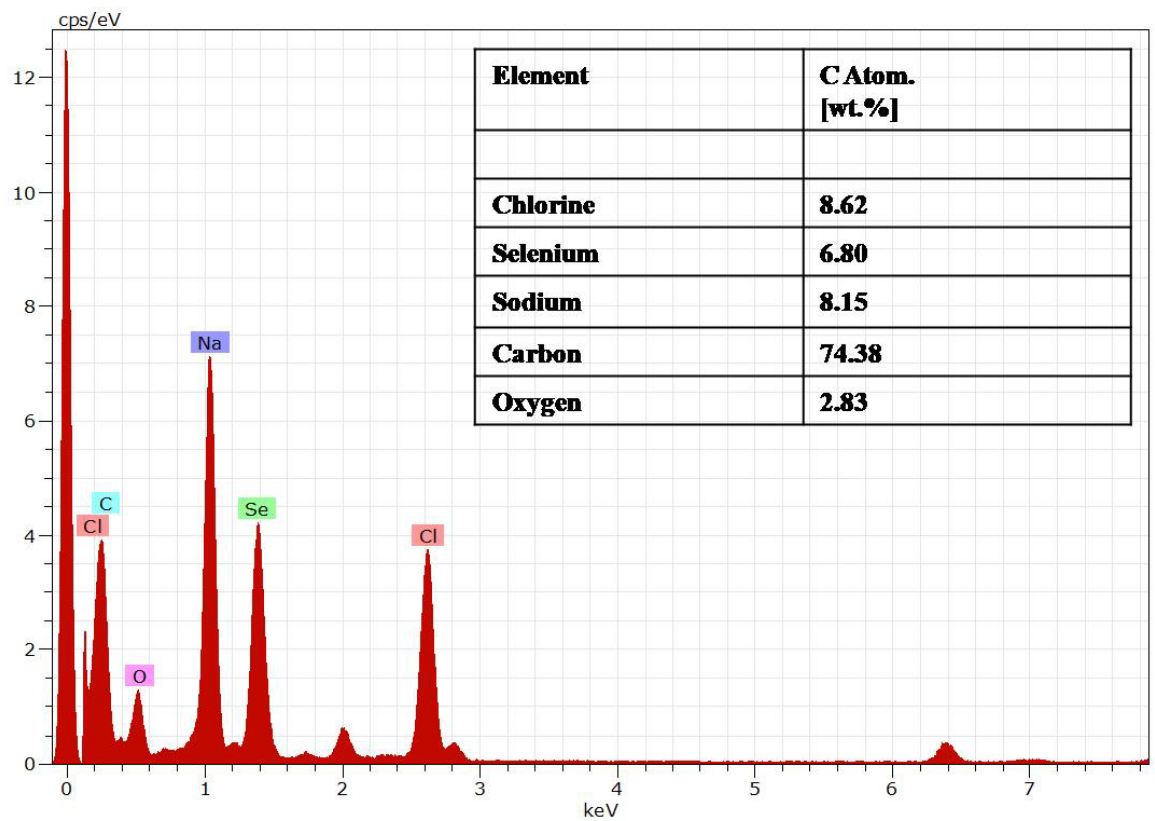
Figure 4. Energy diffraction spectroscopy (EDAX) of the PTX-chit-SeNPs.